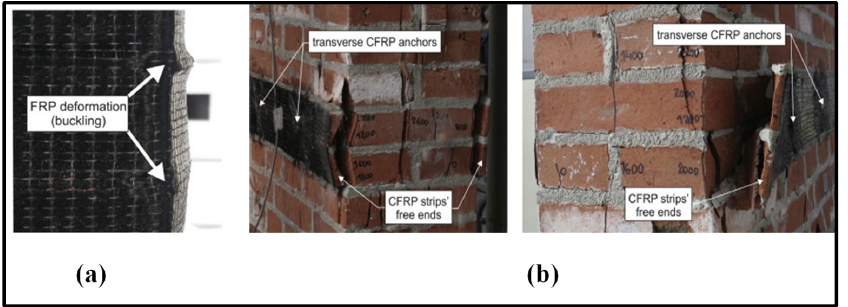
Figure 13. Failure modes on the CFRP-strengthened masonry wallettes (Adapted with permission from [59]); ( a ) CFRP deformation buckling at the edges and ( b ) premature interaction failure initiated at the